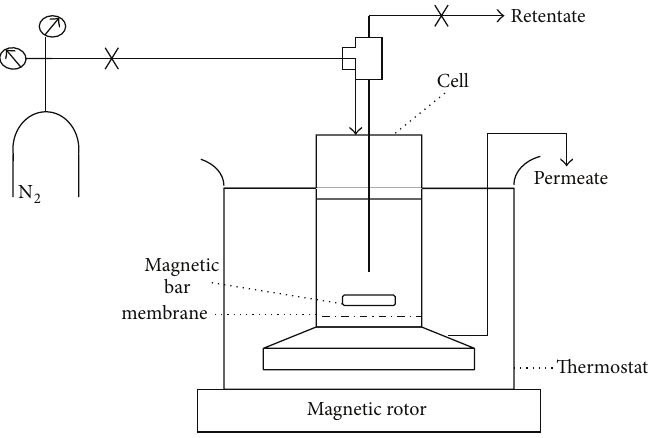
Figure 1: Schematic diagram of dead-end cell.